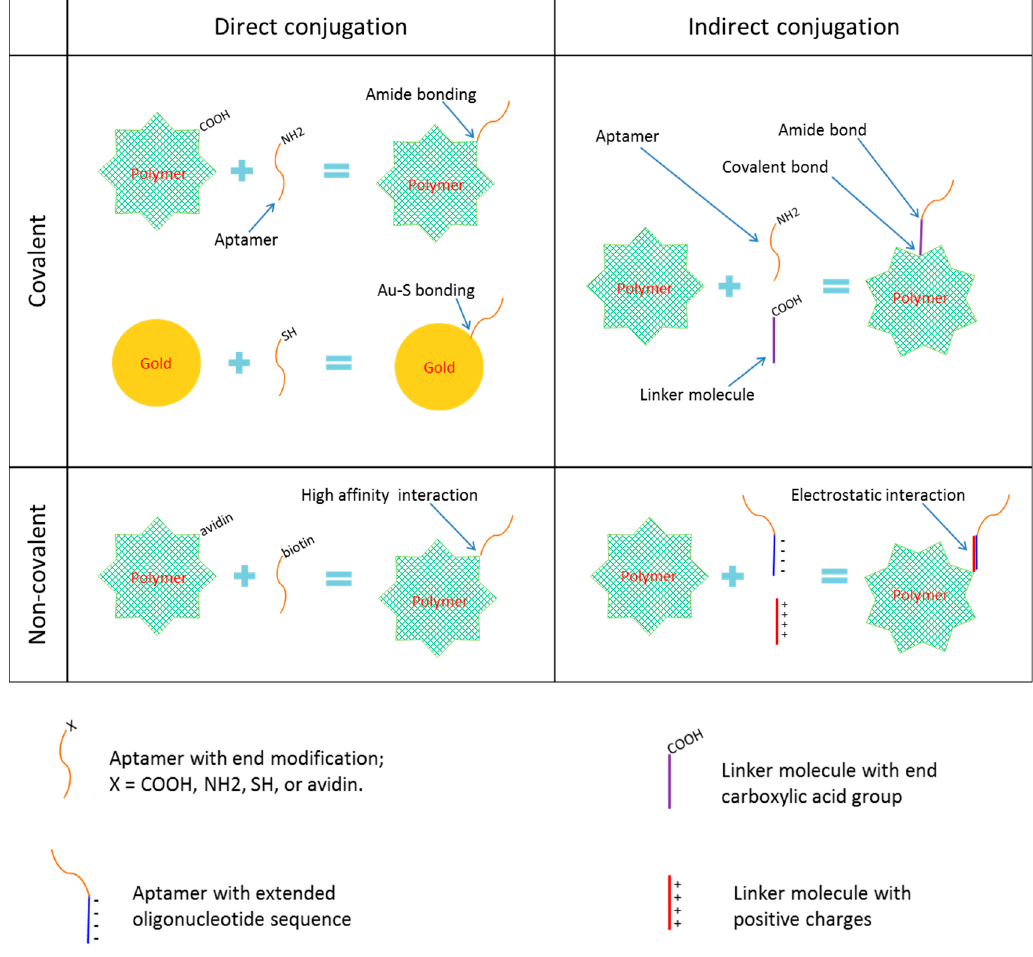
Figure 2. Common strategies of nanoparticle-aptamer conjugation.